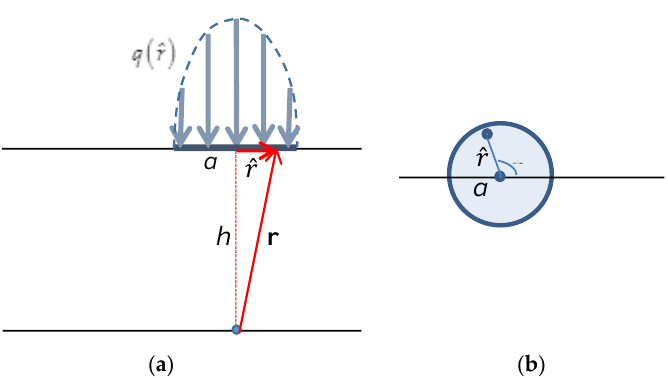
Figure 5. Normal force distributed over circular contact area with Hertzian pressure distribution. ( a ) View side, ( b ) Top side.